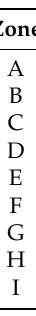
Table 6. Comparison of annotation timed for different zones. Average times rounded to two decimal places and given in